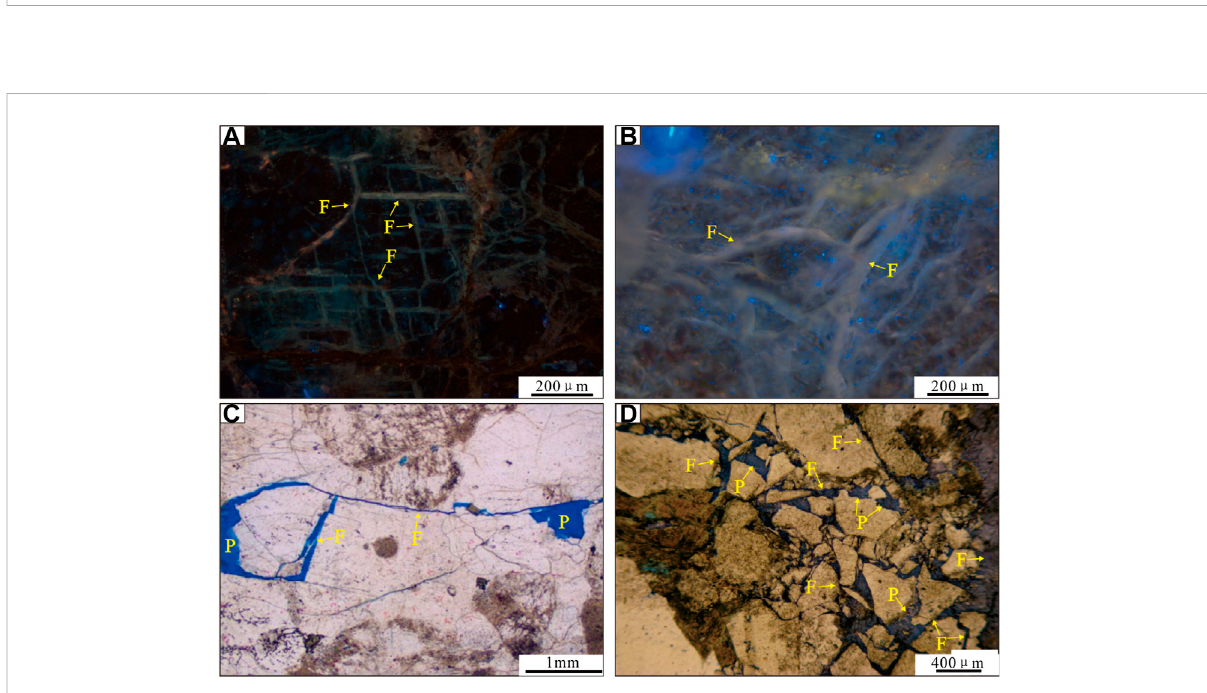
FIGURE 15 Thin-section photomicrographs and fl uorescence scanning photos showing fractures and pores in the Archean metamorphic rocks in the study area. (A) Fractures in migmatitic granite under fl uorescence scanning photos, show signi fi cant oil and gas displays, BZ19-G, 4544 m; (B) Fractures in migmatitic gneiss under fl uorescence scanning photos, show signi fi cant oil and gas displays, BZ13-E, 4628 m; (C) Fractures act as channels to connect the secondary pores BZ19-J, 4903 m; (D) Secondary pores develop along the fractures, BZ19-B, 4432 m; P = secondary pore, F =